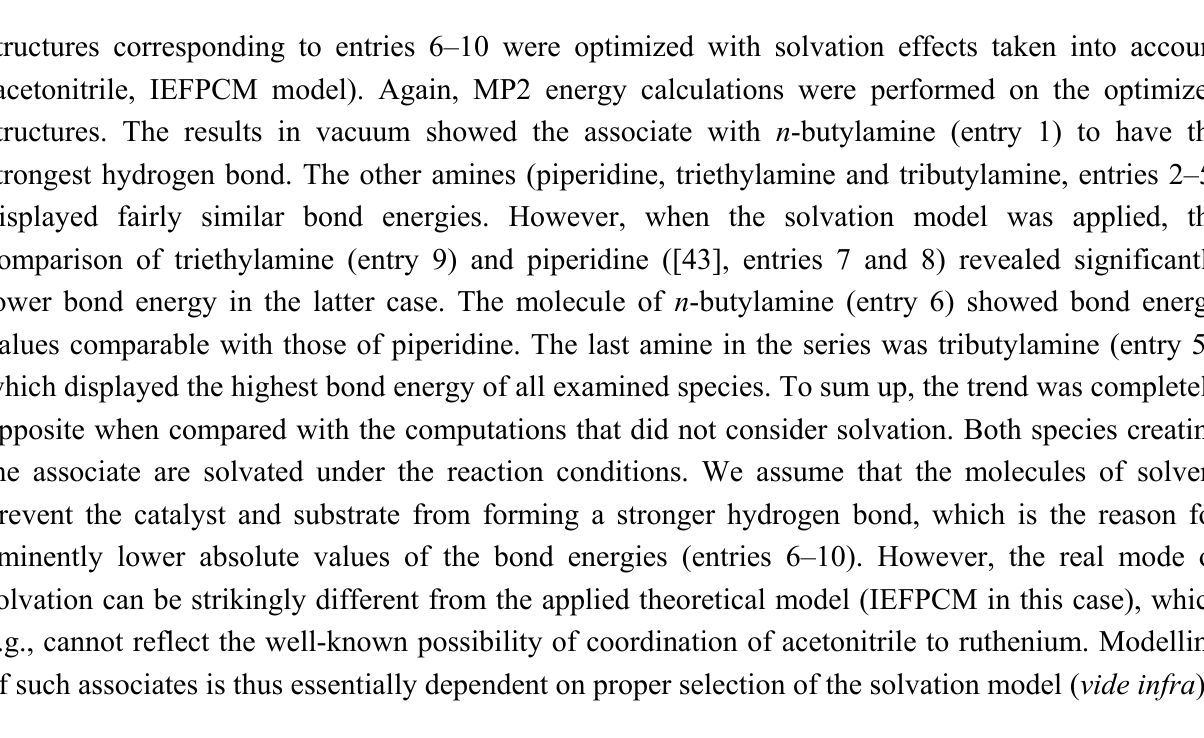
Table 1. Single-point energies and Gibbs free energies of the hydrogen bond between catalyst and protonated amine molecules